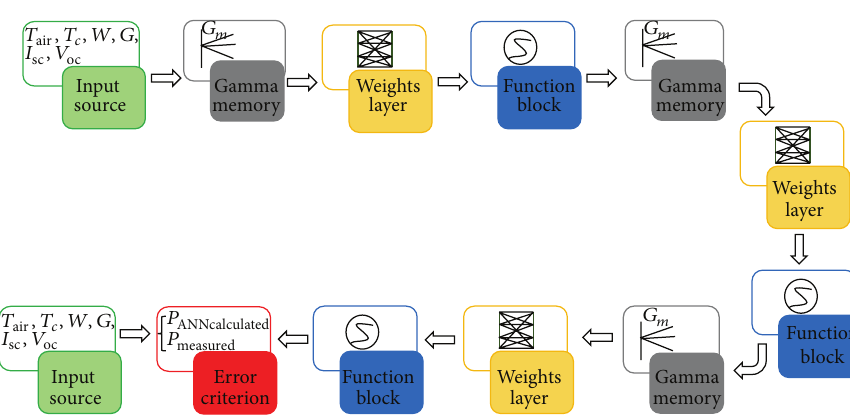
Figure 12: Schema of gamma memory topology for the power output evaluation.